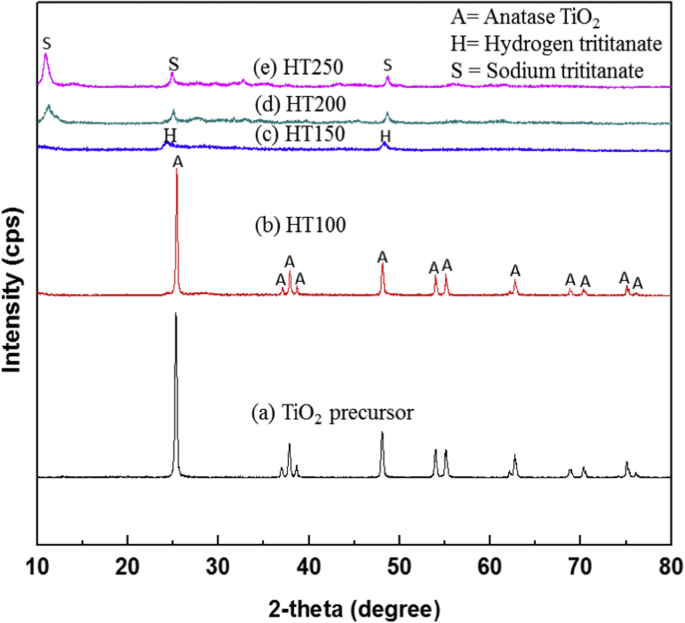
XRD diffractogram of (a) TiO2 precursor, (b) HT100, (c) HT150, (d) HT200, and (e) HT250.